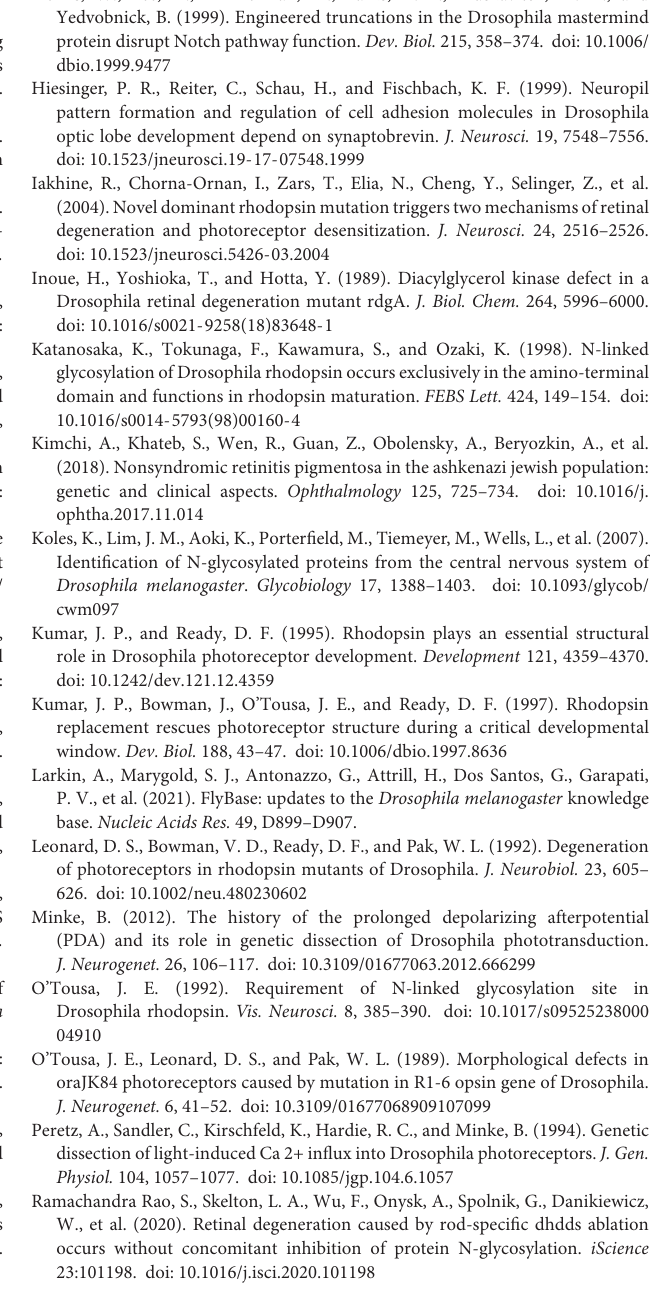
photoreceptors is restricted to the region posterior of the morphogenetic furrow. (E) Merged localization of DAPI and GFP . Supplementary Figure 3 | Retinal TEM section of GMR-DHDDS-RNAi knockdown flies at low magnification showing a pattern of retinal degeneration in the retina. A representative low magnification ( × 300) TEM cross section at a ∼ 55 µ m depth (from the corneal surface), showing an ultrastructure of a newly eclosed GMR-DHDDS-RNAi fly. Note that the typical organized ommatidial structure is preserved (see dotted lines). In addition, most of the rhabdomeres are present, with a degenerated